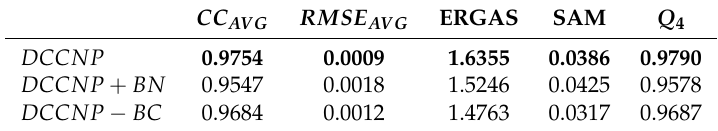
Table 6. Quantitative assessments of different experiment on the QuickBird